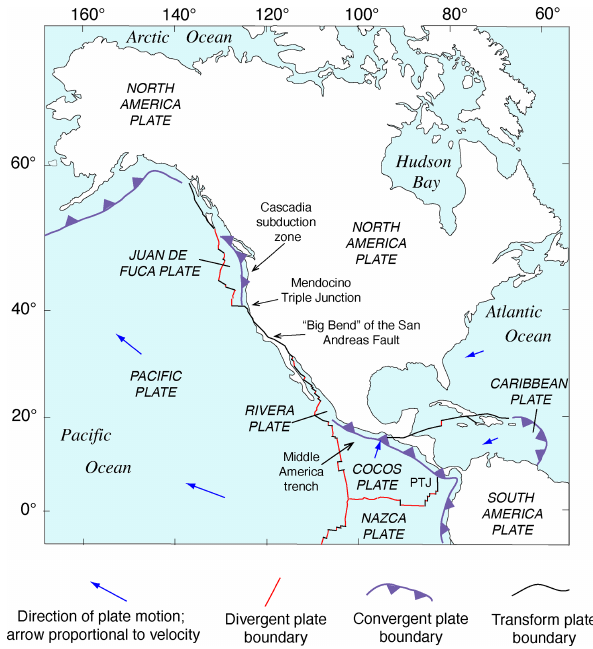
Figure 1. Tectonic setting of North America showing lithospheric plates, plate boundaries, and features referred to in the text. Re- drawn in simplified form from Simkin et al. (2006). PTJ: Panama Triple Junction.